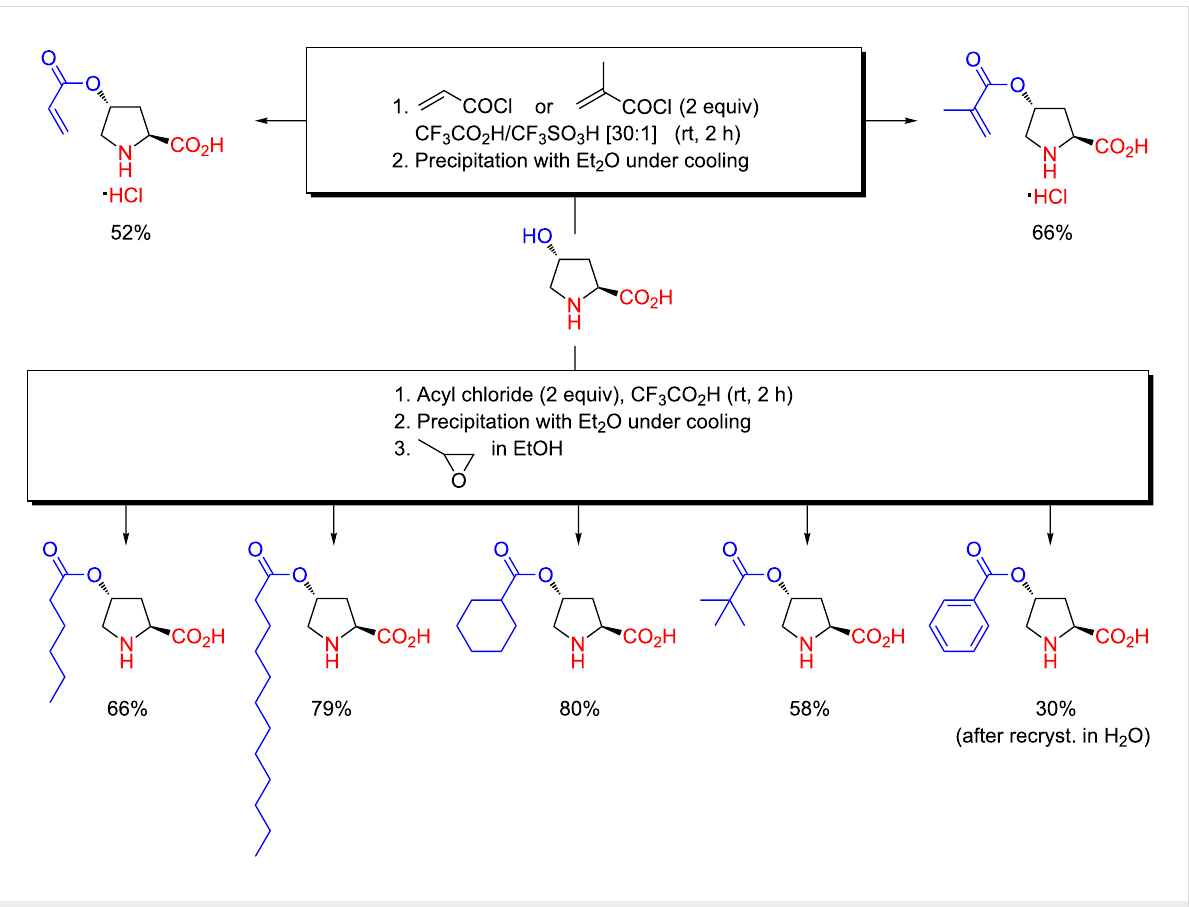
Scheme 9: Preparation of proline amphiphiles or acrylic proline monomers (for macromolecular synthesis) by chemoselective O -acylation of hydroxy- proline in CF 3 CO 2 H or CF 3 CO 2 H–CF 3 SO 3 H as reported in 2009